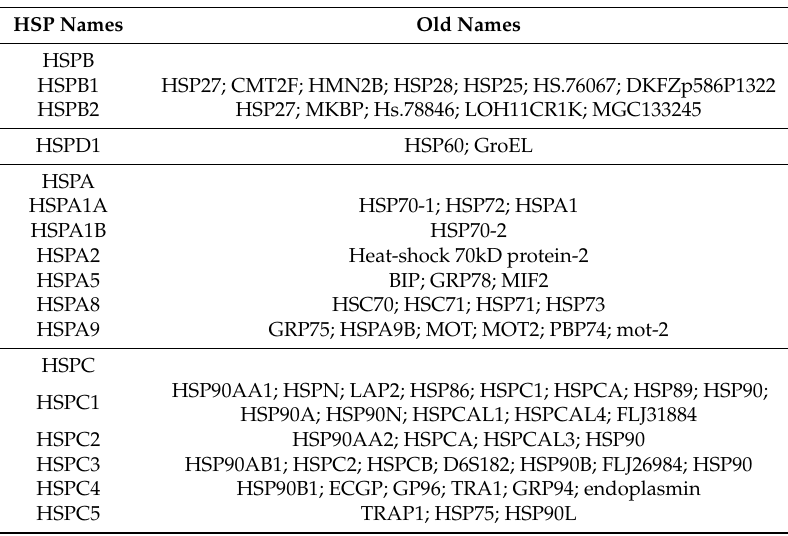
Table 1. HSP Proteins